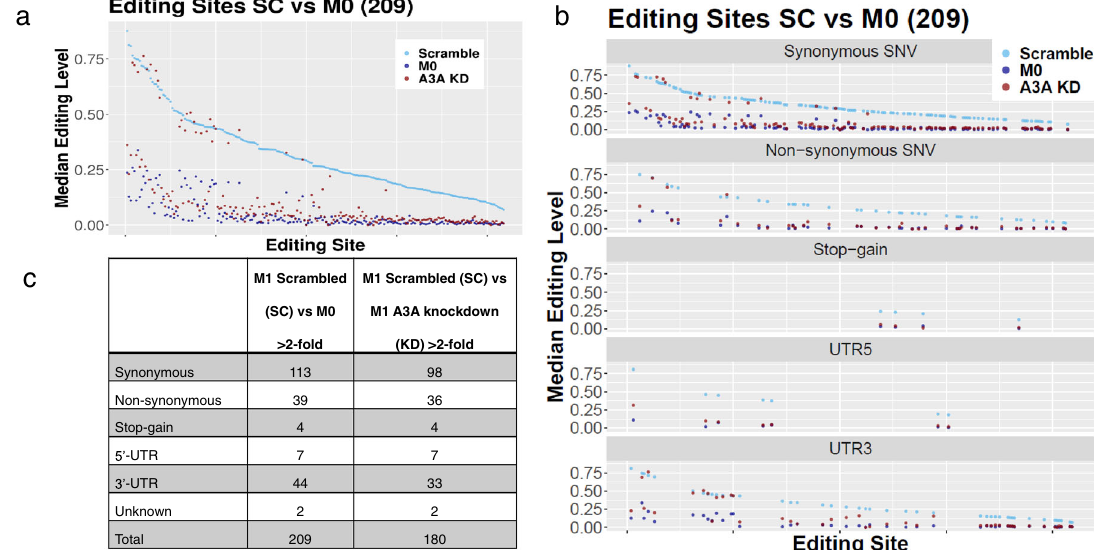
Fig. 3 A3A catalyzes the majority of C>U RNA editing events during M1 polarization. a A3A KD reduces the C>U RNA editing levels in SC M1 macrophages close to levels seen in M0 unpolarized macrophages. C>U RNA editing sites are ranked by their levels in M1 A3A SC control. b and c C>U RNA editing events in M1 A3A SC, M1 A3A KD and M0 cells are separately shown for variant types in A3A KD samples shows reduced expression of A3A protein polarization and reduced editing levels by A3A KD. As expected, by siRNA KD, but similar amounts of THOC5 protein, suggesting M0 macrophages showed no evidence of RNA editing (Fig. 4b). that missense alteration by RNA editing does not alter THOC5 Together, these results demonstrate that mRNAs of certain genes protein stability (Fig. 4a). Other genes including ZNF124, ARSB, are substantially altered by A3A-mediated RNA editing in M1- ATXN2, SLC37A2, GAA, PCGF3, CDYL2 , and S1PR2 also showed polarized macrophages. high levels (>20%) of non-synonymous RNA editing in M1 A3A SC compared to M1 A3A KD macrophages (Table 1). Sanger sequencing of RT-PCR products obtained from a A3A upregulates pro-in fl ammatory gene expression in M1 different monocyte donor con fi rmed high-level (~50%) of RNA macrophages . Relative to A3A SC, A3A KD caused more than 2- editing in THOC5 and ZNF124 gene transcripts during M1 fold downregulation of 81 genes and upregulation of 131 genes